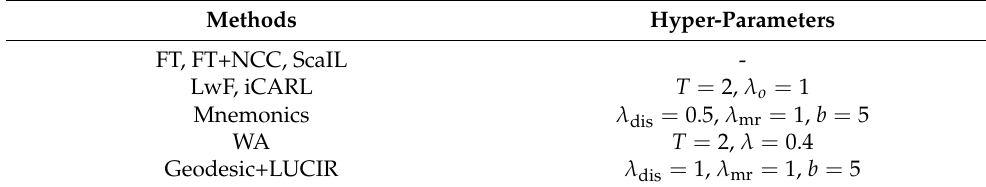
Table 2. Hyper-parameter setting. a , b are margins; λ , λ o , λ dis , λ mr , are the trade-off hyperparameters for each CIL